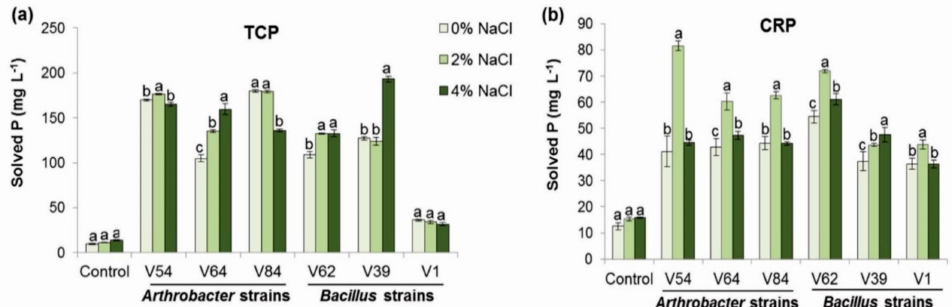
Figure 3. E ff ect of di ff erent NaCl concentrations on phosphate-solubilizing abilities of bacterial strains. ( a ) Amount of P (mg L − 1 ) released from tricalcium phosphate (TCP), and ( b ) amount of P (mg L − 1 ) released from Cameroonian RP (CRP) by the di ff erent bacterial strains at 0%, 2%, and 4% of NaCl. Results are the mean values of three replicates for each treatment. Error bars represent the standard deviation and di ff erent letters above the error bars (a,b,c) indicate significant salt e ff ects for each strain separately ( p < 0.05) using the Tukey HSD test. Control = NBRIP medium supplied either with TCP or CRP without bacterial